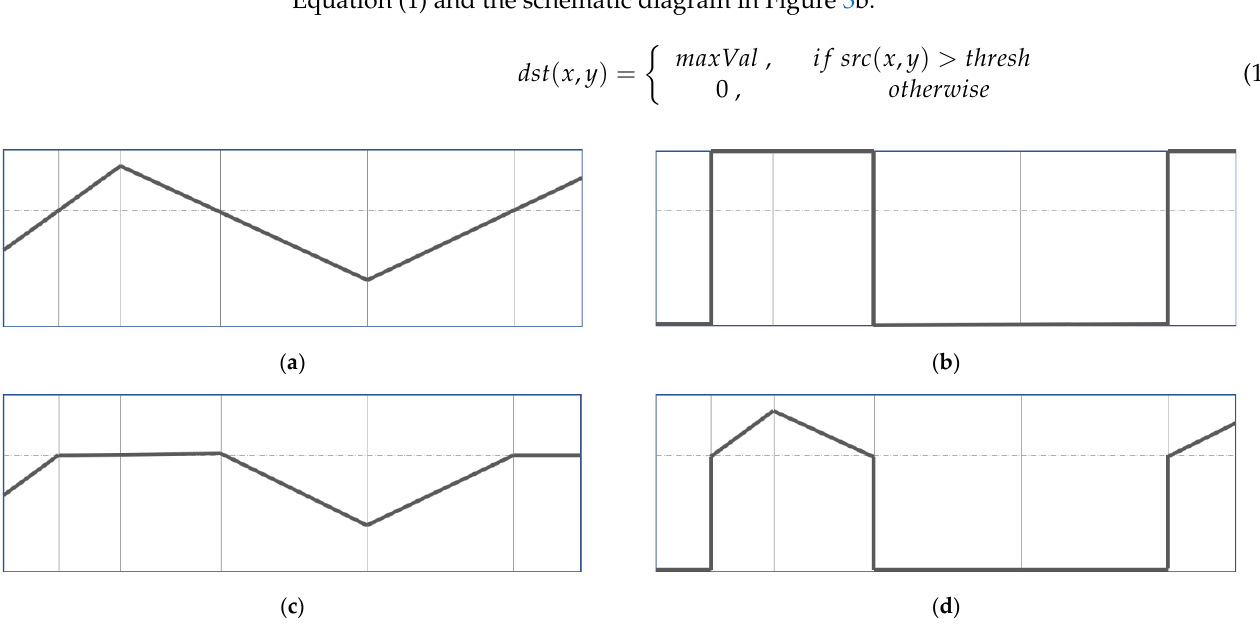
Figure 3. ( a ) Assumed pixel value distribution, ( b ) distribution after binary threshold, ( c ) distribution after the truncated threshold, and ( d ) distribution after ToZero threshold.